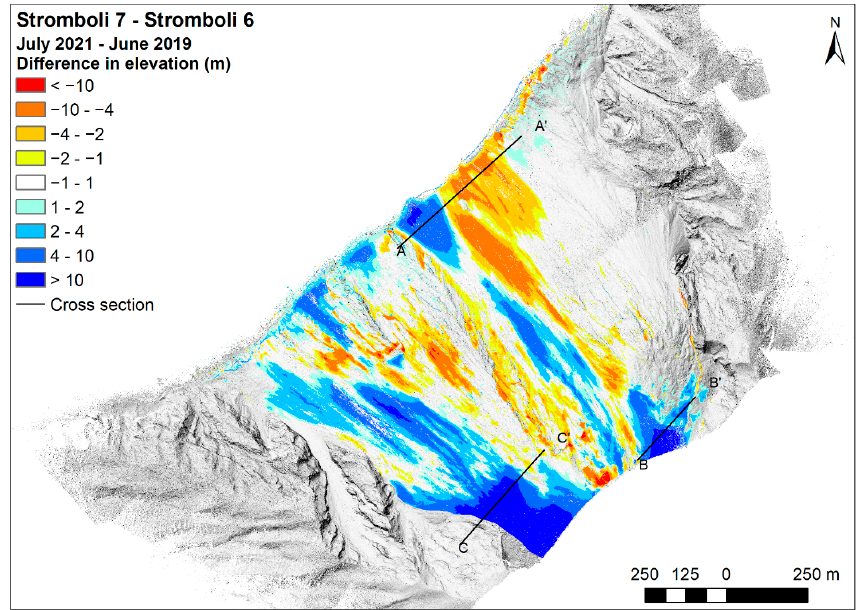
Figure 7. Difference in elevation between Stromboli 7 and Stromboli 6 Digital Surface Models, generated from two UAV-based photogrammetric surveys carried out in July 2021 and June 2019, respectively.